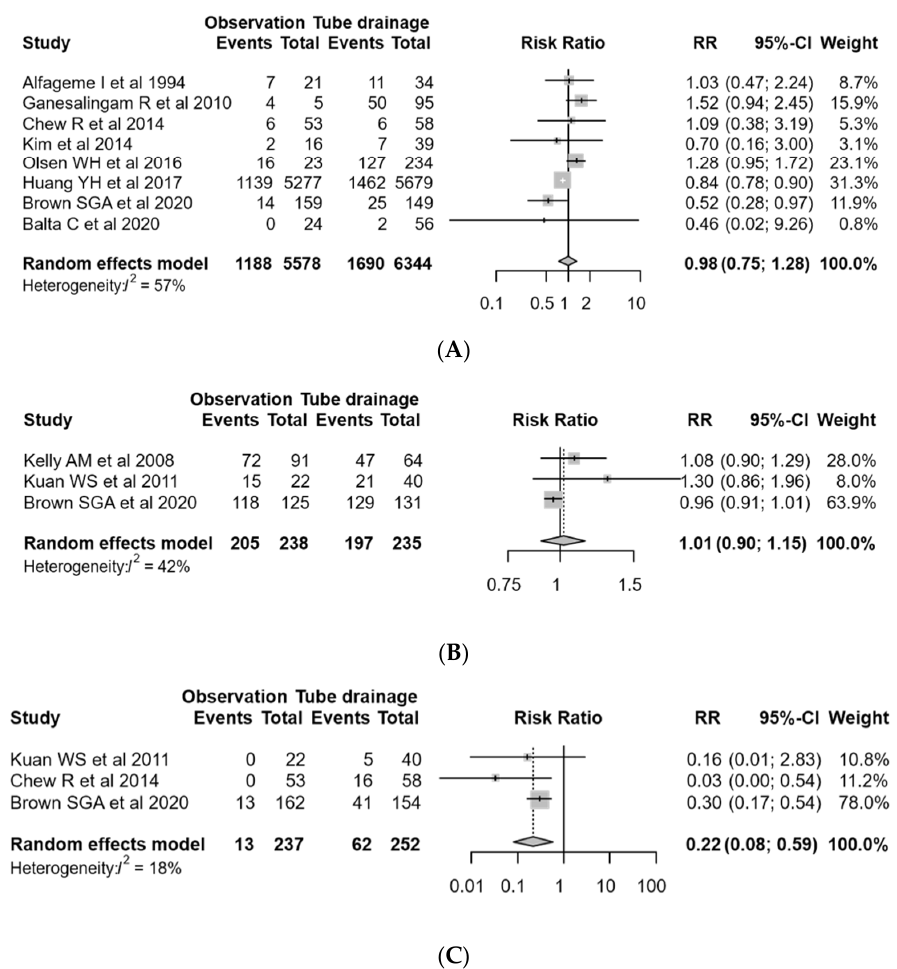
Figure 2. Forest plot comparing conservative management and chest tube drainage for primary spontaneous pneumothorax (PSP). ( A ) Recurrence of PSP, ( B ) resolution of PSP, and ( C ) adverse events during treatment.